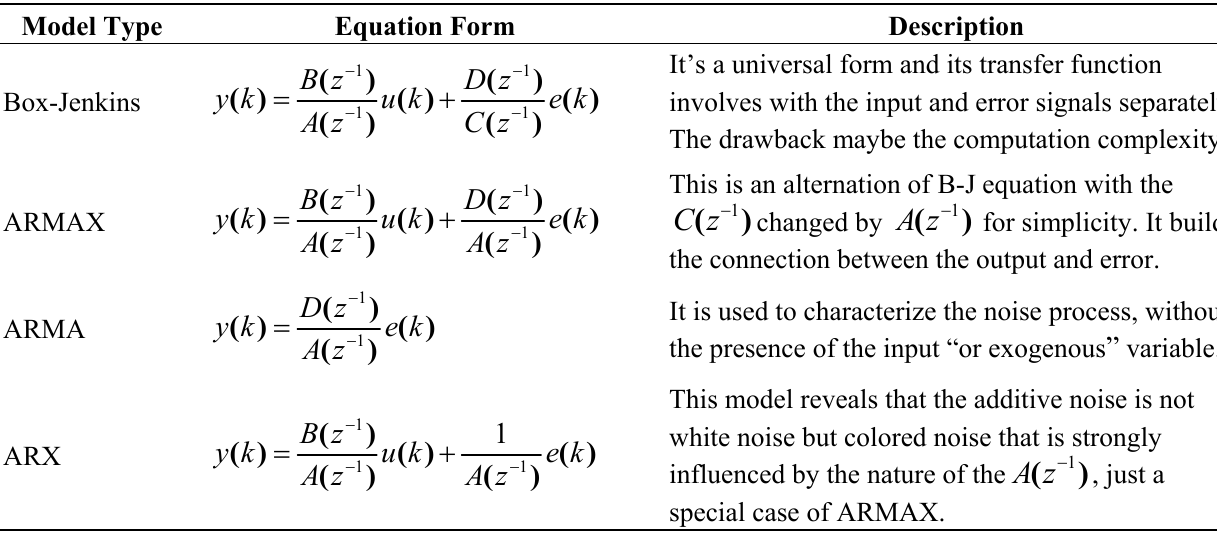
Table 1. Summary of the time series